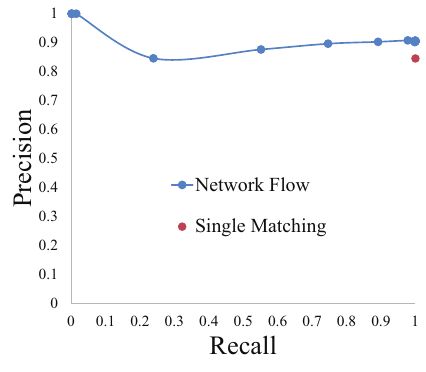
Figure 17. The precision–recall curve derived by tuning parameter c , and the precision and recall obtained by single-image matching.